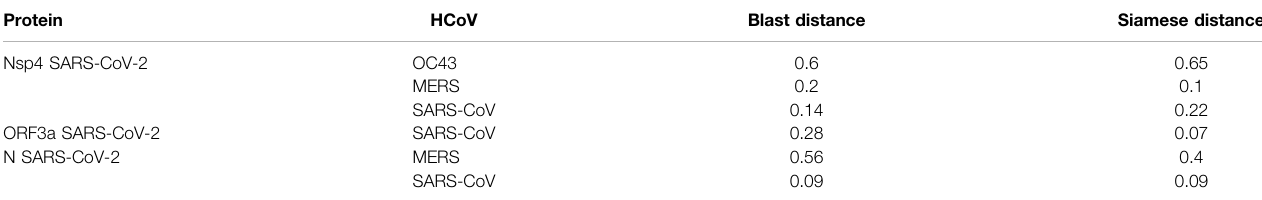
TABLE 4 | Best comparison of BLAST and the Siamese network distance score in COVID protein set after fi ltering the test data set. Protein